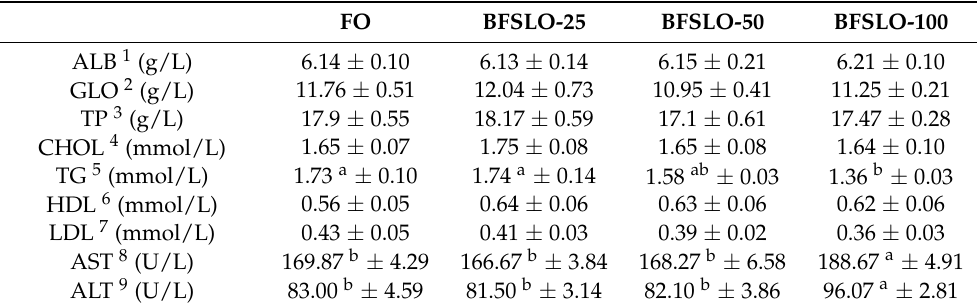
Table 6. Serum biochemical indices of O.macrolepis fed the four experimental diets with different gradient levels of BSFLO (25%, 50% and 100%) replacing FO (control) for eight